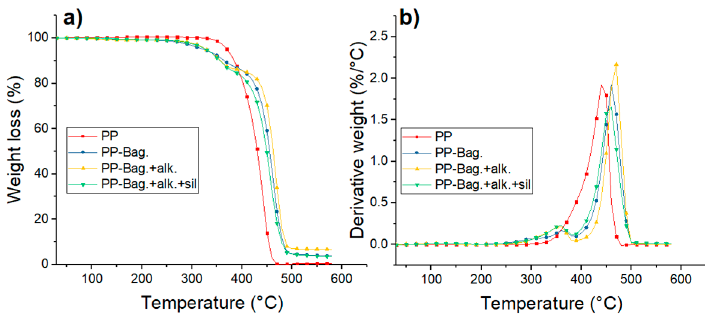
Figure 8. ( a ) TG and ( b ) DTG curves for third processing cycle PP and PP-Bagasse biocomposites.